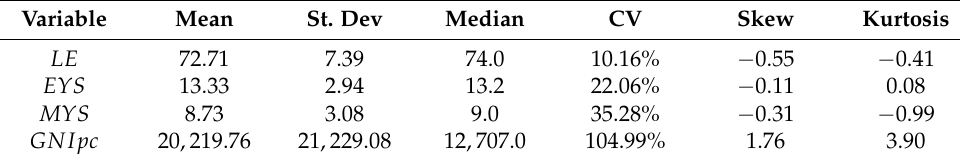
Table 2. Descriptive statistics for the variables used to compute the HDI